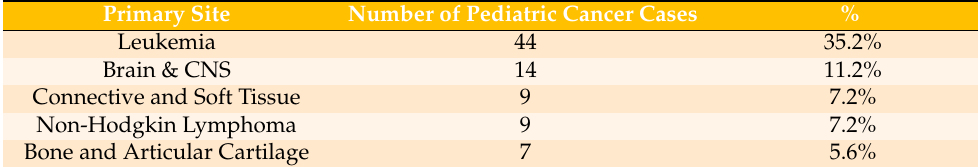
Table 6. Distribution of the top five pediatric cancer cases by primary sites in UAE, 2019.